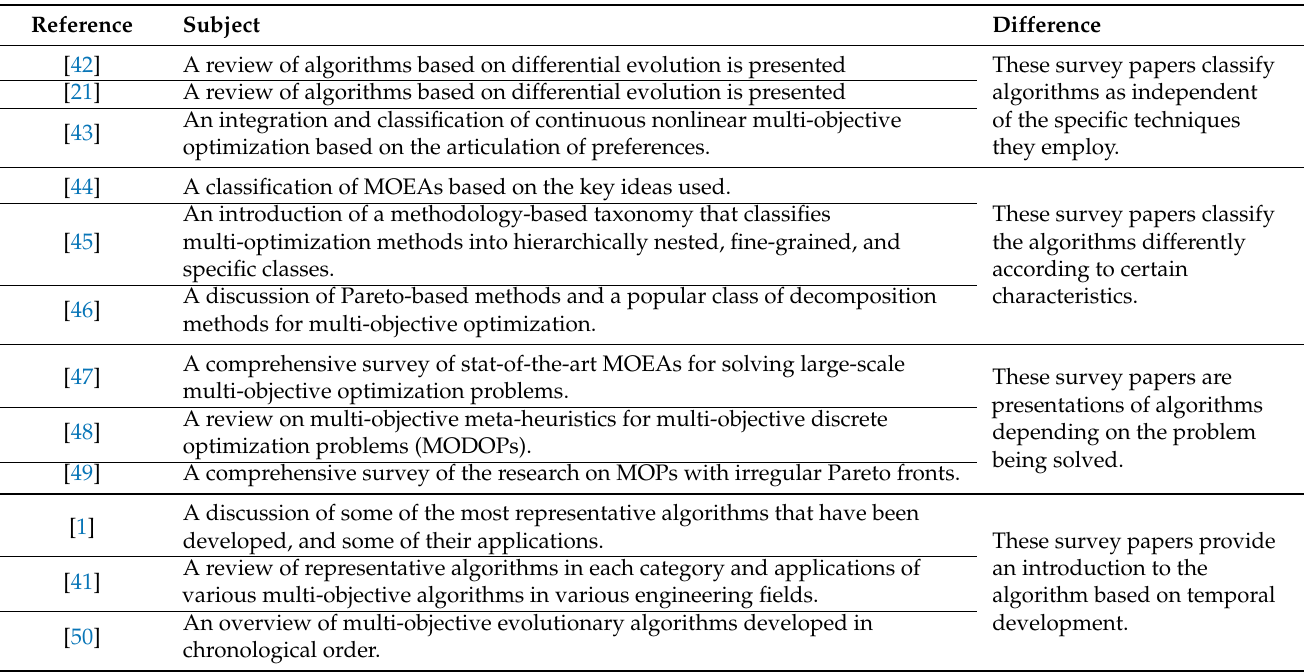
Table 1. The surveys in the references can be broadly divided into four categories and find the differences between